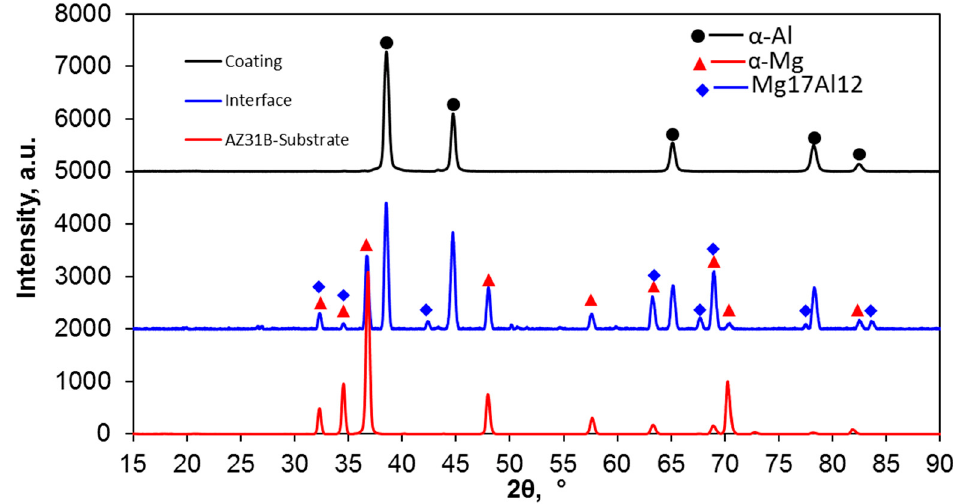
Figure 4. The XRD patterns of the AZ31B Mg alloy coated with AA7075 alloy in coating interface.